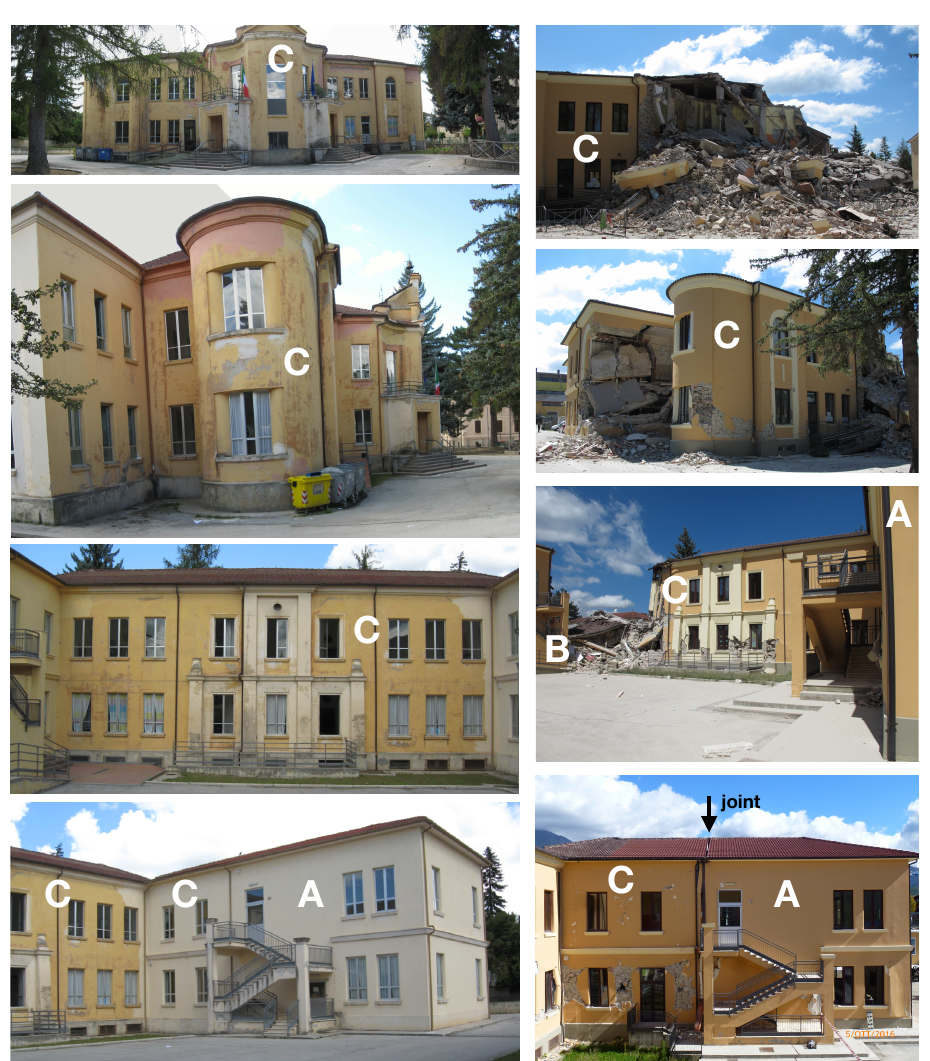
Figure 2. Views of the buildings before ( left ) and after ( right ) the 24 August 2016 earthquake; the letters refer to the nomenclature of the buildings reported in Figure 1b. The photographs on the left were taken prior to the 2012 interventions.